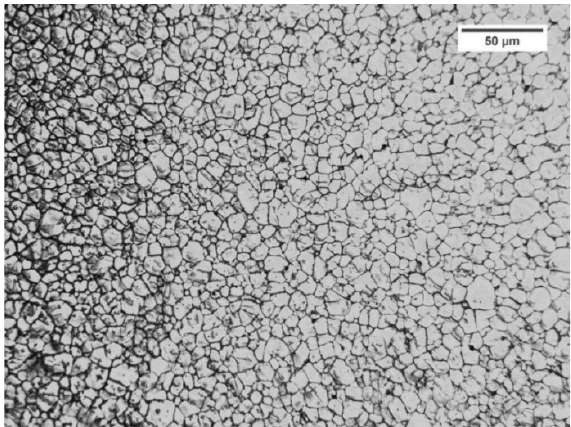
Figure 1. Optical micrograph of the longitudinal section of the bar of Inconel 625.